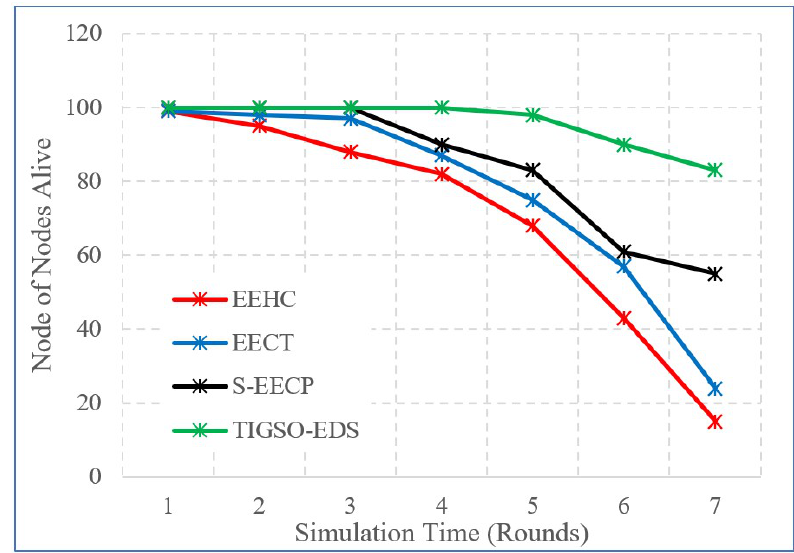
Figure 4. Comparison of alive nodes (base station located at 50 × 50).